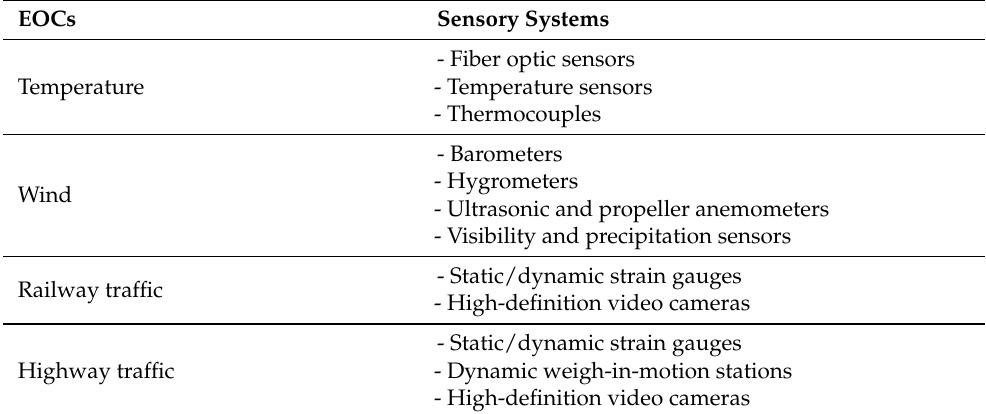
Table 4. Typical EOCs and appropriate sensors for SHM systems [141]. EOCs Sensory Systems Temperature